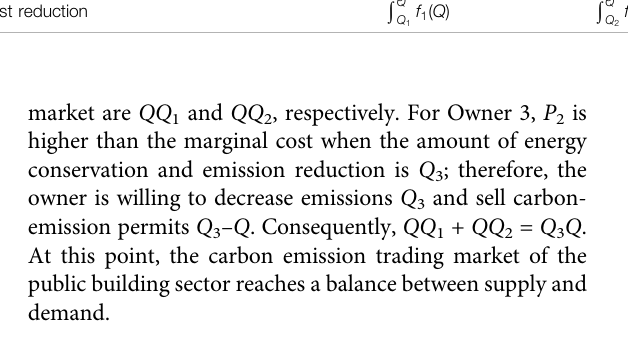
TABLE 1 | Comparison of carbon-emission reduction between owner participating in trade and not participating in trade. Owner Owner 1 Owner 2 Owner 3 Cost when carbon price is P 1 or P